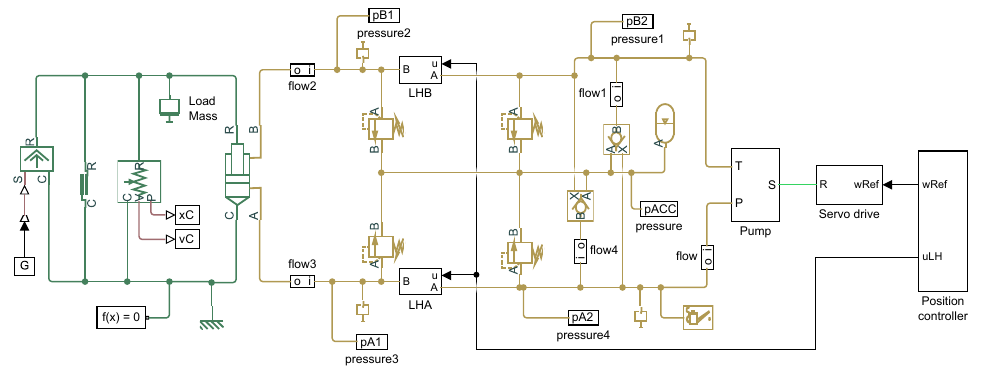
Figure 12. Simscape model of the EHA.